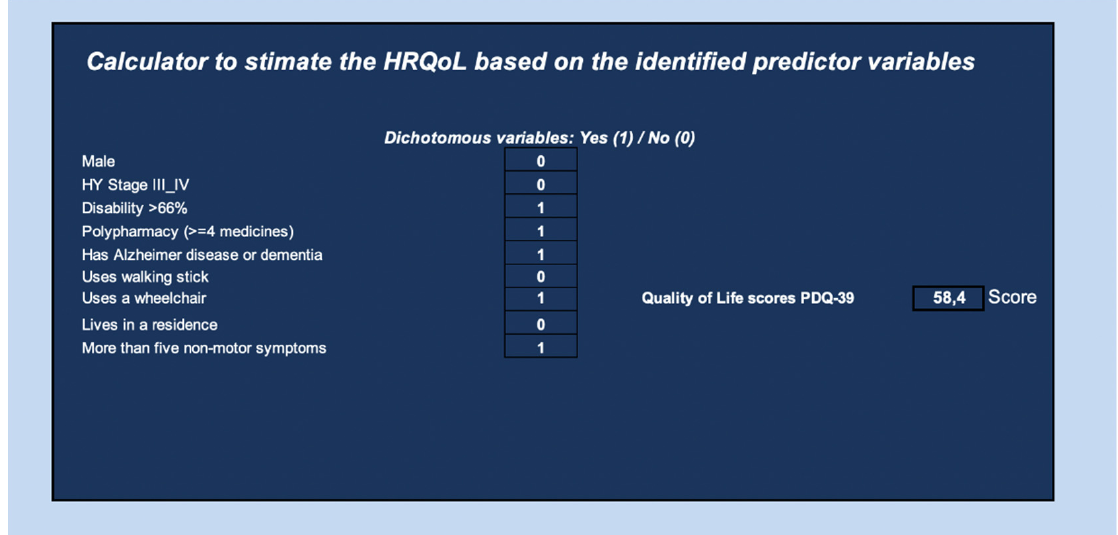
Figure 5. Quality of life scores PDQ-39. Automatic calculator.